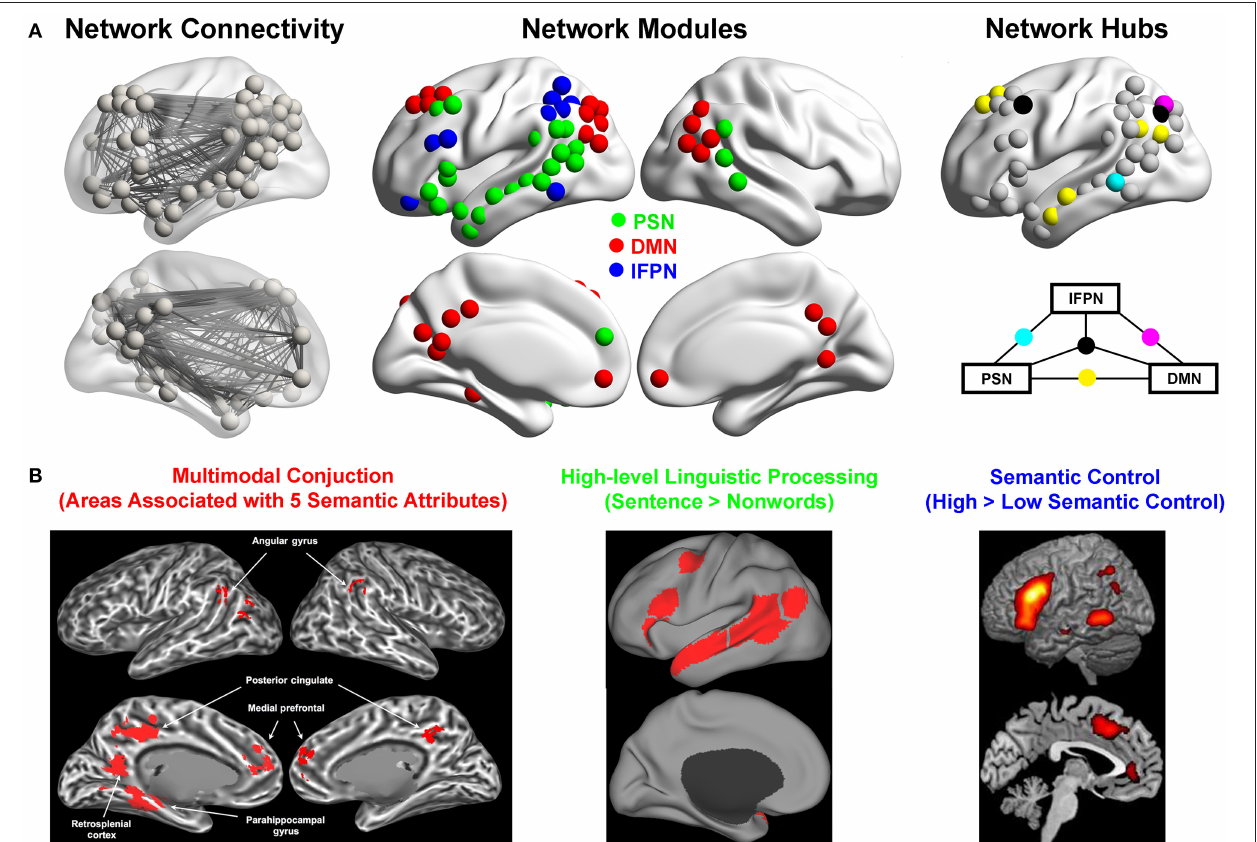
FIGURE 2 | Semantic functional network: modules, hubs, and their cognitive functions. (A) The organization of the intrinsic functional network of semantic processing. Left: the semantic network showing nodes and edges, with nodes defined as the regions consistently activated during semantic processing obtained from a meta-analysis (Binder et al., 2009), and edges defined as the resting-state functional connectivity strength; Middle: the modules of the semantic network obtained by applying a graph-theoretic approach to the underlying connection patterns. Right: The connector hubs linking the three modules. Reproduced with permission from Xu et al. (2016). (B) Example results from task-evoked fMRI studies that shed light on the functions of the three modules. Left: The conjunction areas of five semantic aspects including shape, sound, motion, color, and manipulation from 900 words, which resemble the areas of Module DMN. Reprinted with permission from Fernandino et al. (2016); Middle: High-level linguistic processing regions generated from the group-level language localizer from 220 participants, which resemble the brain areas of Module PSN (https://evlab.mit.edu/funcloc/download-parcels); Right: The semantic control areas generated from a meta-analysis of 53 studies, which resemble the areas of Module lFPN. Reproduced with permission from Noonan et al.